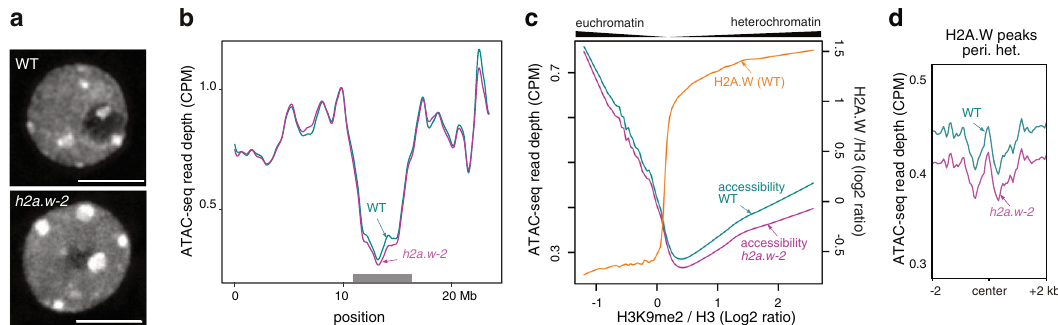
Fig. 3 Loss of H2A.W alters heterochromatin organization and accessibility. a Representative images of DAPI-stained WT (Col-0) and h2a.w-2 leaf interphase nuclei. Two independent experiments were performed with similar results. Scale bar is 5 µ m. b Locally weighted scatterplot smoothing (LOESS) fi t of ATAC-seq read depth averaged in 1 kb bins across chromosome 3 in WT and h2a.w-2 . Average of two replicates shown. The gray rectangle indicates the location of pericentromeric heterochromatin. c Smoothing spline fi t (50 degrees of freedom) of WT H2A.W levels (log 2 ChIP-seq H2A.W/H3) and of ATAC-seq read depth (CPM normalized) in WT and h2a.w-2 in 1 kb windows plotted against WT H3K9me2 level. d ATAC-seq read depth over